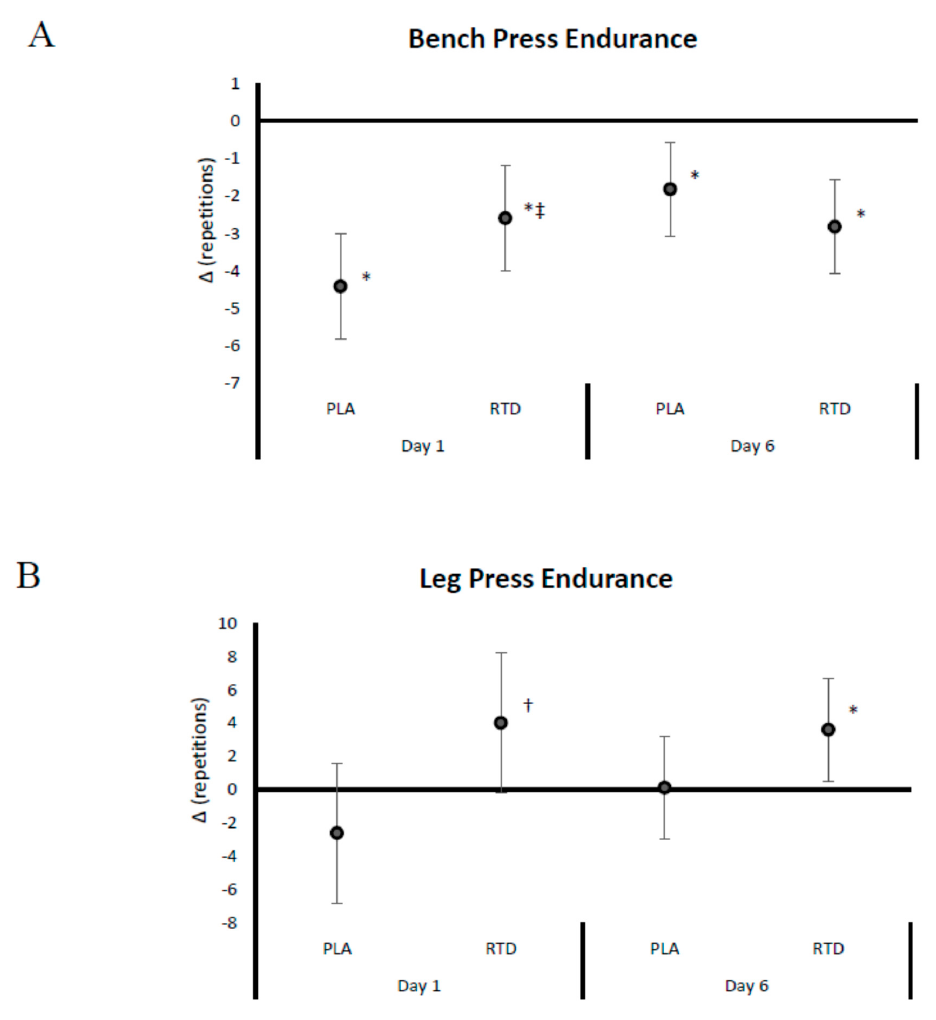
Figure 3. Data present mean change (95% CI) in bench press ( A ); and leg press ( B ) muscular endurance repetitions to failure at 70% of one repetition maximum (1-RM) from baseline. Confidence intervals not crossing zero are statistically significant ( p < 0.05). * Represents p < 0.05 difference from baseline, † represents p < 0.05 difference between treatments. ‡ Represents p > 0.05 to 0.10 tendency towards significance between treatments.